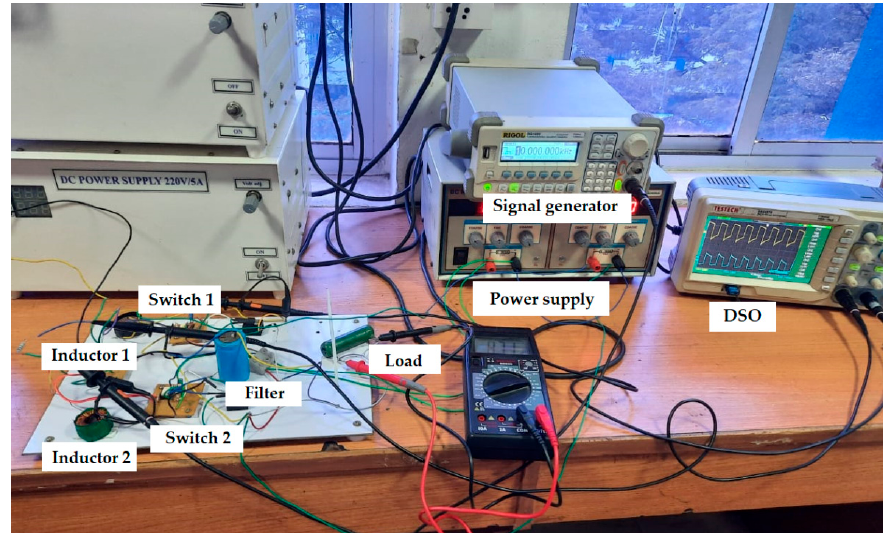
Figure 9. Hardware prototype for MPIBC (two phase).